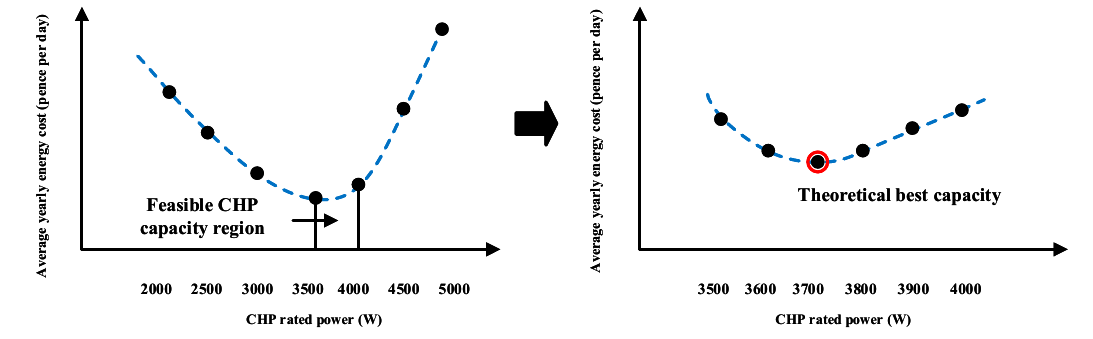
Figure 2. Using the GA method to find the theoretical best CHP capacity.